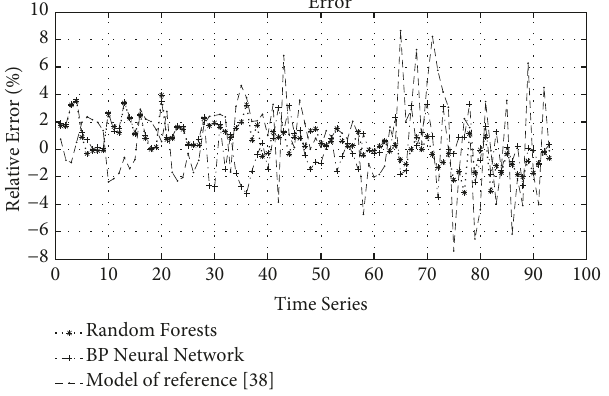
Figure 8: The relative error of the